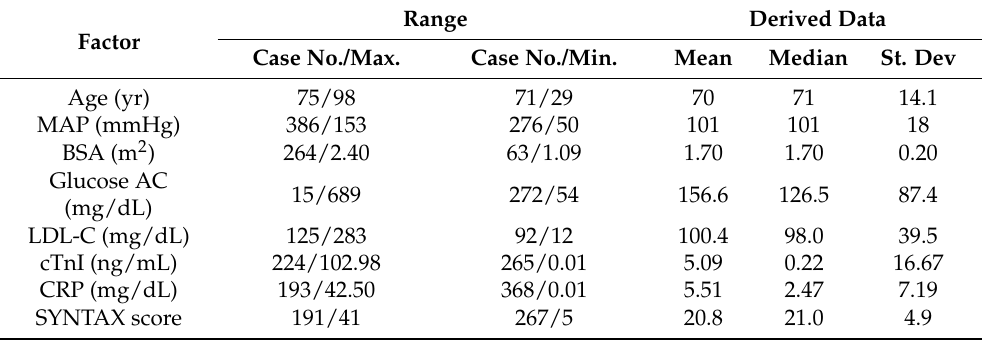
Table 1. The readings of seven factors and actual (original) SYNTAX scores before the normalization process for 405 patients with cardiovascular artery diseases having their cardiac diagnoses reported in the Taichung Armed Forces General Hospital, Taiwan, from 2016 to 2021. Range Derived Data Factor Case No./Max. Case No./Min. Mean Median St.